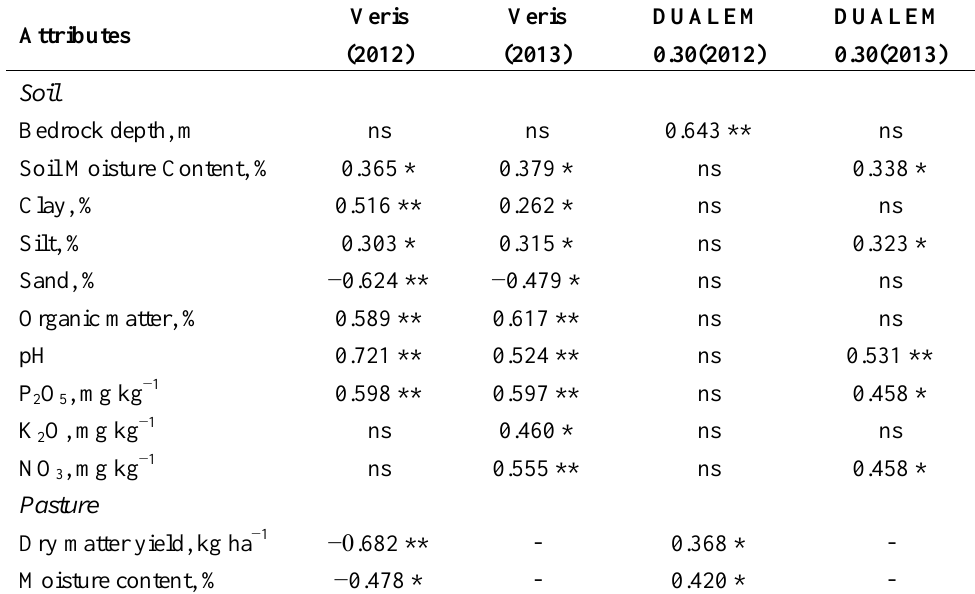
Table 3. Correlation coefficients between the EC Veris and DUALEM sensors) and soil and pasture parameters.